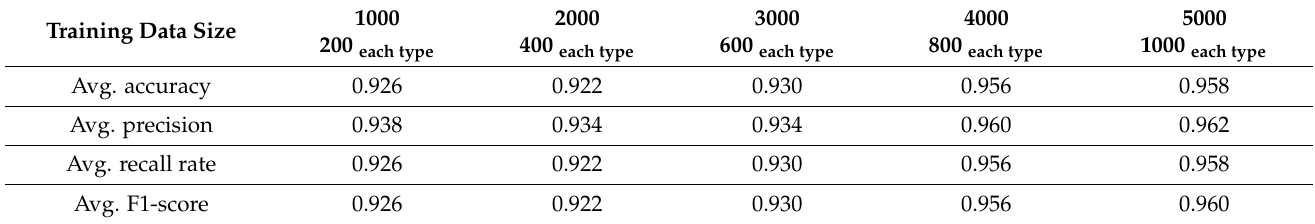
Table 8. Xception